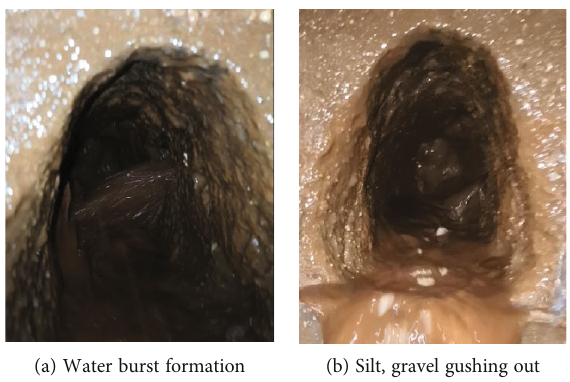
Figure 12: Photograph of water and mud inrush in the tunnel fault fracture zone during the